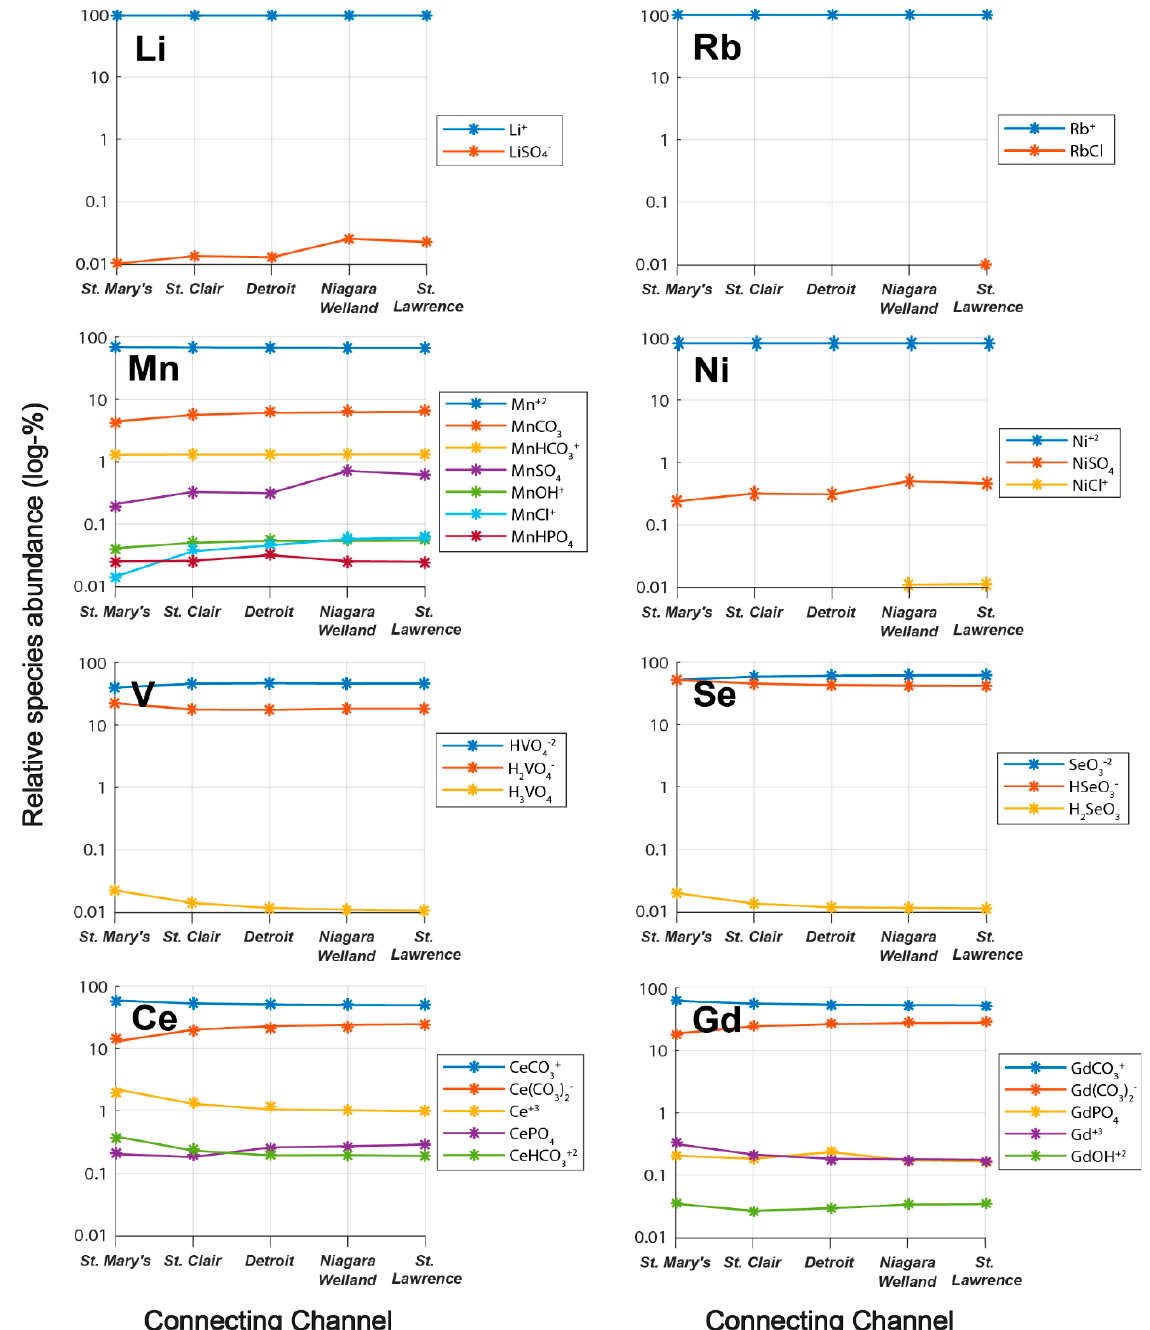
Figure 2. Geochemical equilibrium modelling of the aqueous speciation of select trace elements in the connecting channels of the Great Lakes basin. Plotted is the share of major individual aqueous species per-total (molality basis), upstream-to-downstream for the connecting channels; additional species present at a <0.01% share are not shown.